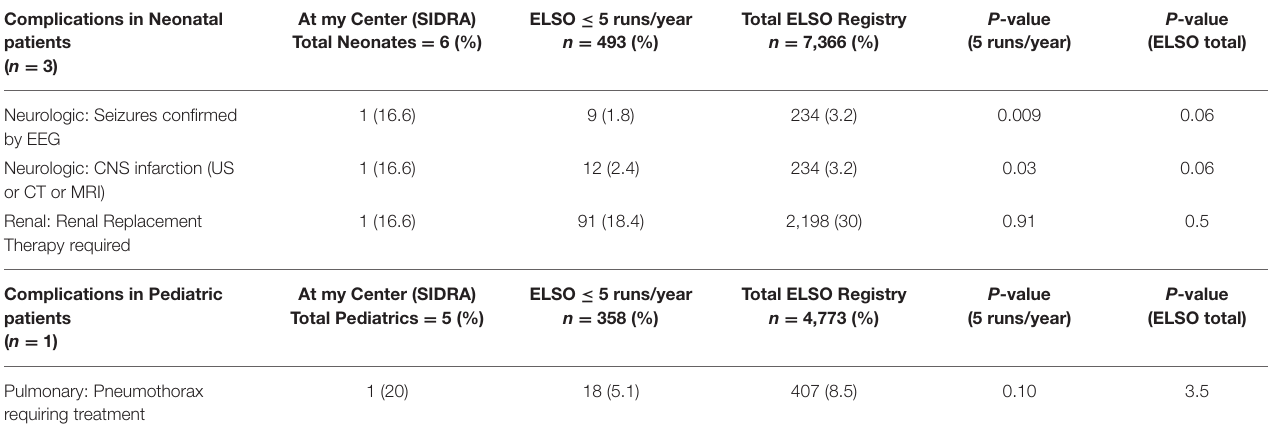
TABLE 4 | Benchmarking of Clinical complications in SIDRA ECMO program against ELSO registry data. Complications in Neonatal